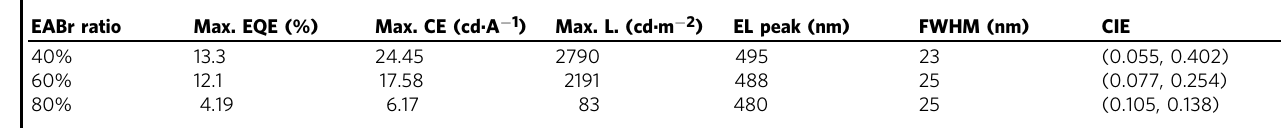
Table 1 Summary of quasi-2D perovskite LEDs with different ratios of EABr. EABr